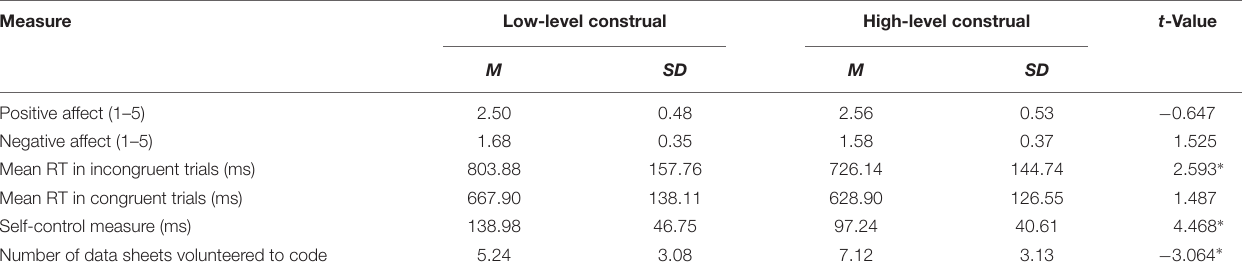
TABLE 1 | Descriptive statistics for the measures in Experiment 1.